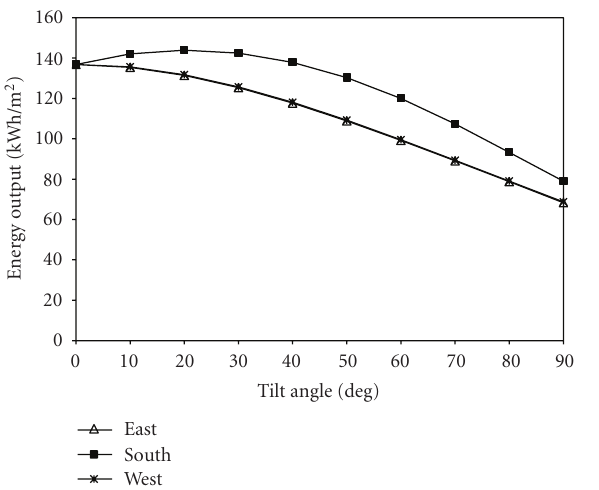
Figure 10: Monetary payback for various tilt angles and orienta-